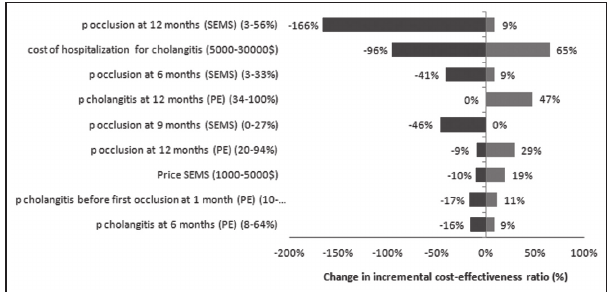
Figure 2) Tornado diagram for variations of ≥ 20% and from the base-case incremental cost-effectiveness ratio (ICER) estimate. p Probability of; PES Polyethylene stent; SEMS Partially covered self expandable metal